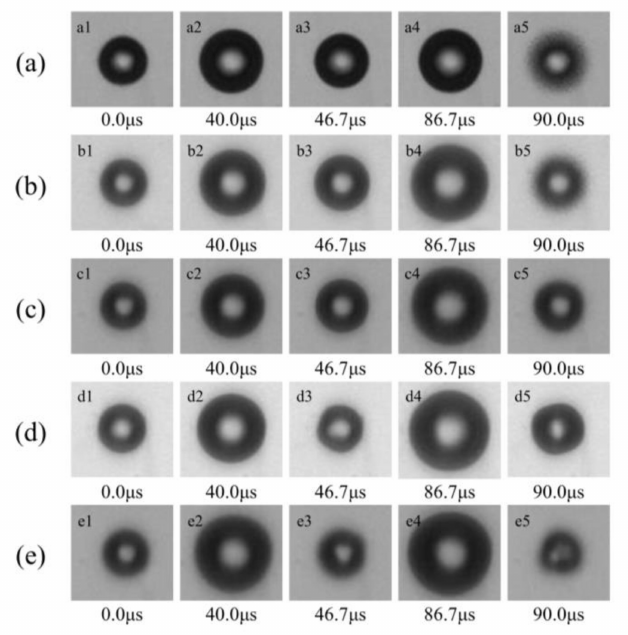
Figure 3. Temporal evolutions of the single bubble in free-field exposed to ultrasound in ( a ) Liquid A (surface tension σ = 72.59 mN/m); ( b ) Liquid B (surface tension σ = 58.75 mN/m); ( c ) Liquid C (surface tension σ = 49.34 mN/m); ( d ) Liquid D (surface tension σ = 38.47 mN/m); ( e ) Liquid E (surface tension σ = 27.13 mN/m). ( R 0 = 20 µ m, T = 21 ◦